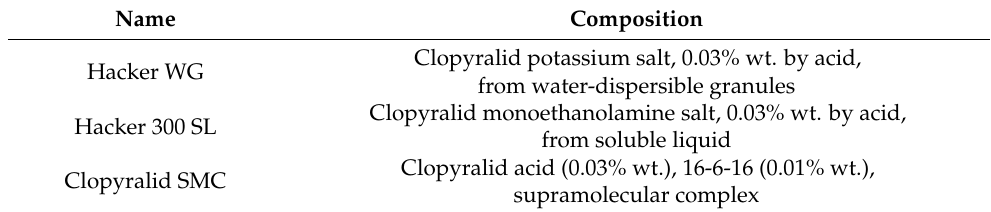
Table 1. Clopyralid formulations used in the